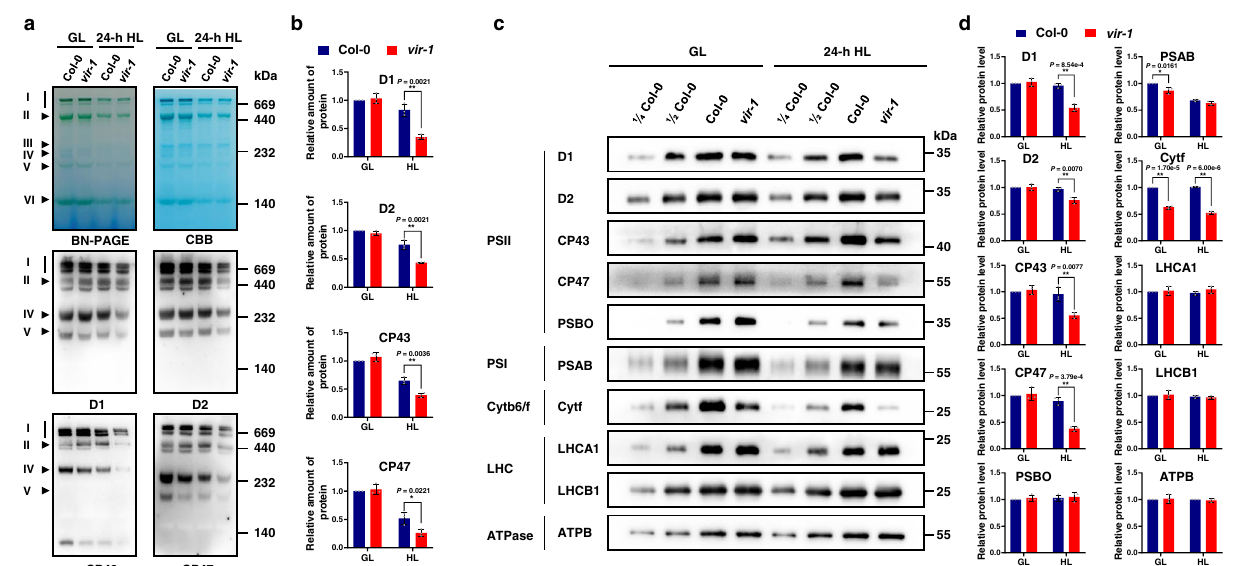
Fig. 3 | Analysis of PSII complexes and subunits in Col-0 and vir-1 seedlings. a BN-PAGEandimmunoblotanalysisofthylakoidphotosyntheticcomplexes.Equal amounts of thylakoid membrane (10 μ g chlorophylls) from Col-0 and vir-1 seed- lingsunder0-h(GL)and24-h(HL)highlighttreatmentweresolubilizedwith2%n- dodecyl- β -D-maltoside (DM) and separated by BN-PAGE. The BN-PAGE gel was stained with Coomassie brilliant blue (CBB). The macromolecular protein com- plexesofthylakoidmembranes(indicatedontheleft)wereidenti fi edaccordingto Jin 48 . For BN-PAGE immunoblot analysis, an equal amount of chlorophyll (1.5 μ g) was loaded in each lane, and anti-D1, anti-D2, anti-CP43, and anti-CP47 antisera wereusedtoprobethePSIIcomplex.I:PSII-LHCIIsupercomplex;II:PSIIdimer,PSI monomer; III: PSI monomer, CF1; IV: Cyt b 6 f , PSII core monomer; V: CP43-less PSII core monomer; VI: LHCII trimer. All experiments involved three independent biological replicates, which produced similar results. b Proteins immunodetected